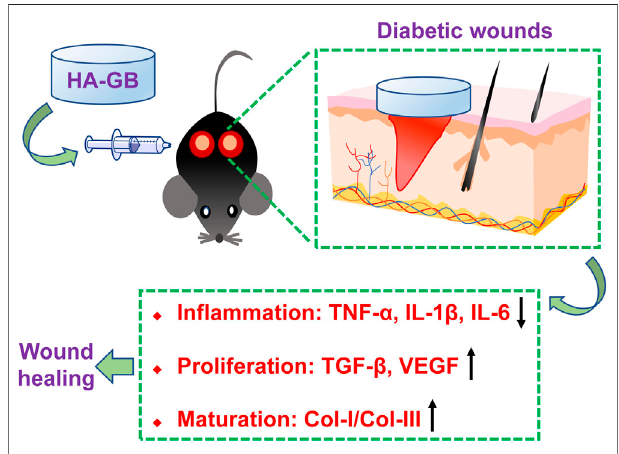
FIGURE8| LocaladministrationofGinkgolideBusingahyaluronicacid- based hydrogel improves wound healing in diabetic mice.